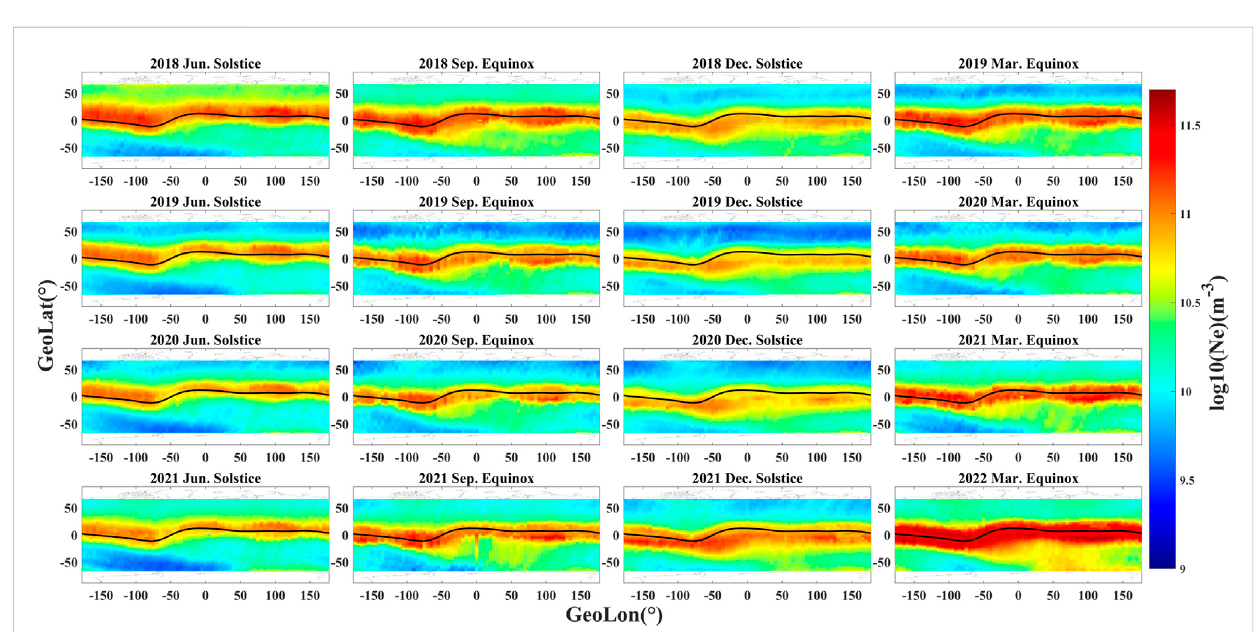
FIGURE 3 Global distribution of Ne in the daytime. From top to bottom represent different years of the same season, and from left to right correspond to different seasons: Jun. solstice (May-August), Sep. equinox (September-October), Dec. solstice (November to February of the following year), and Mar. equinox (March-April). The black solid line marks the magnetic equator. Ne is colored according to the colorbar on the right. The month information for each subplot is marked at the